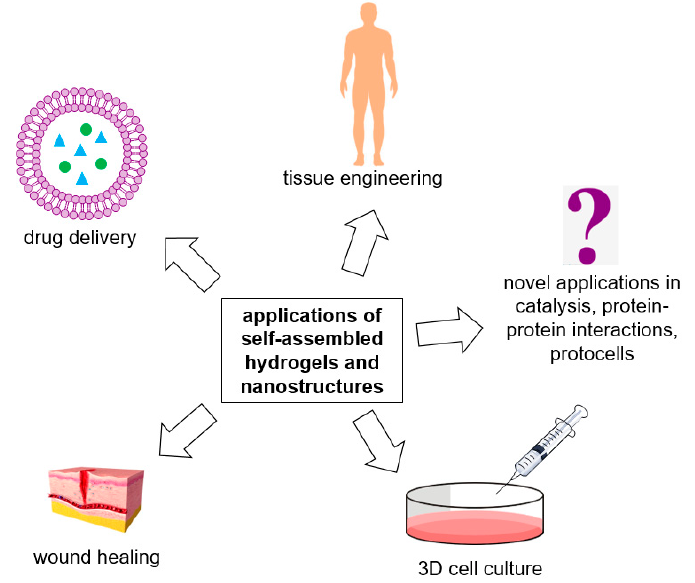
Figure 8. Summary of current and possible future direction of self-assembled hydrogels and nanostructures.